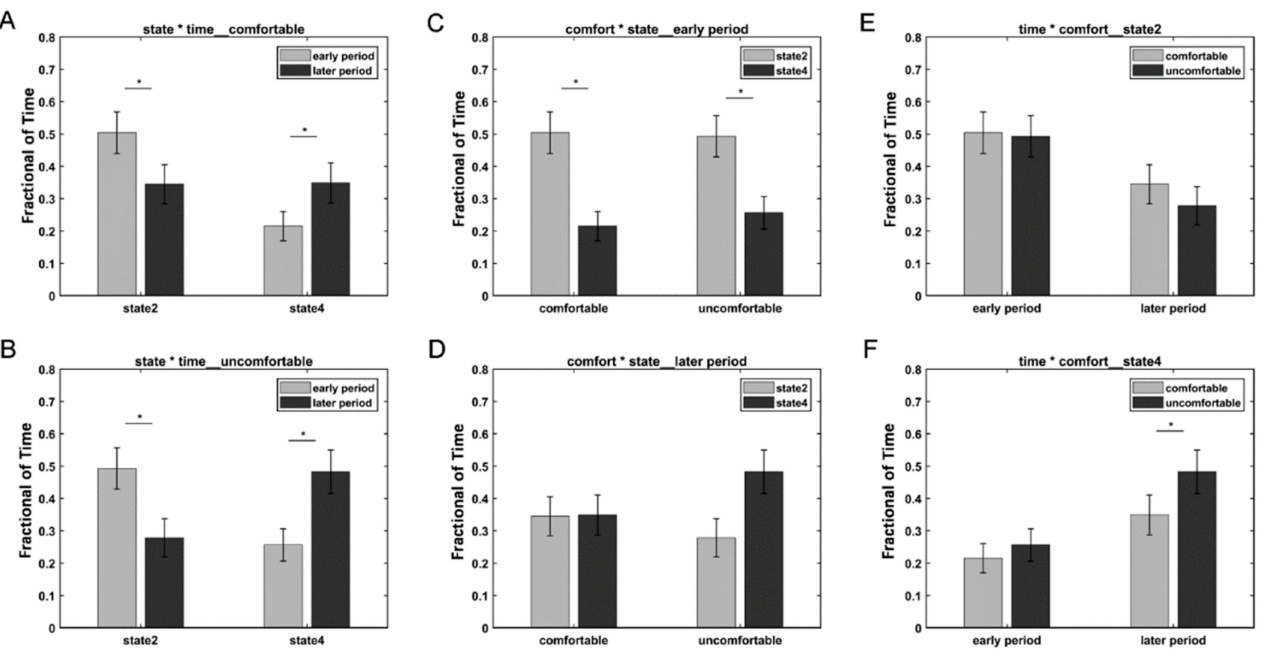
Figure 4. Results of the simple effects of the period ( A , B ), state ( C , D ), and condition ( E , F ). The star * represents p <